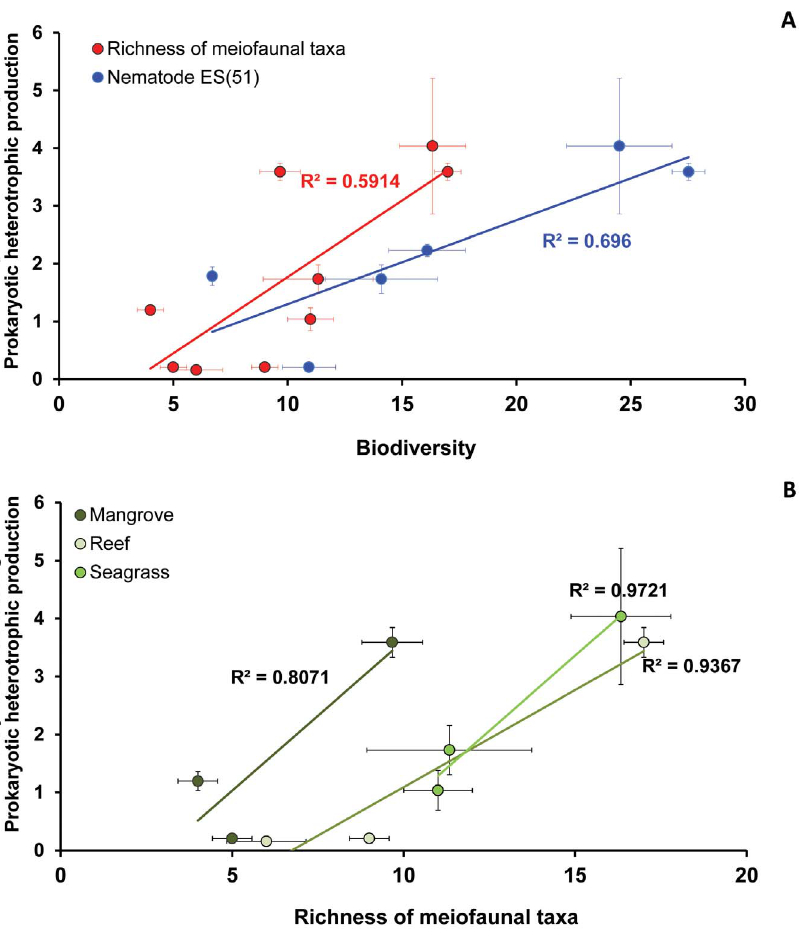
Figure 8. Relationship between biodiversity and ecosystem functioning. Illustrated are the relationships between: A) richness of meiofaunal taxa and prokaryotic heterotrophic production ( m gC g 2 1 d 2 1 ); nematode diversity as ES(51) and prokaryotic heterotrophic production ( m gC g 2 1 d 2 1 ); B) richness of meiofaunal taxa and prokaryotic heterotrophic production in different habitat types. Reported are R 2 values. P , 0.01 for all linear regressions. Error bars indicate standard deviations among replicates (n=3).